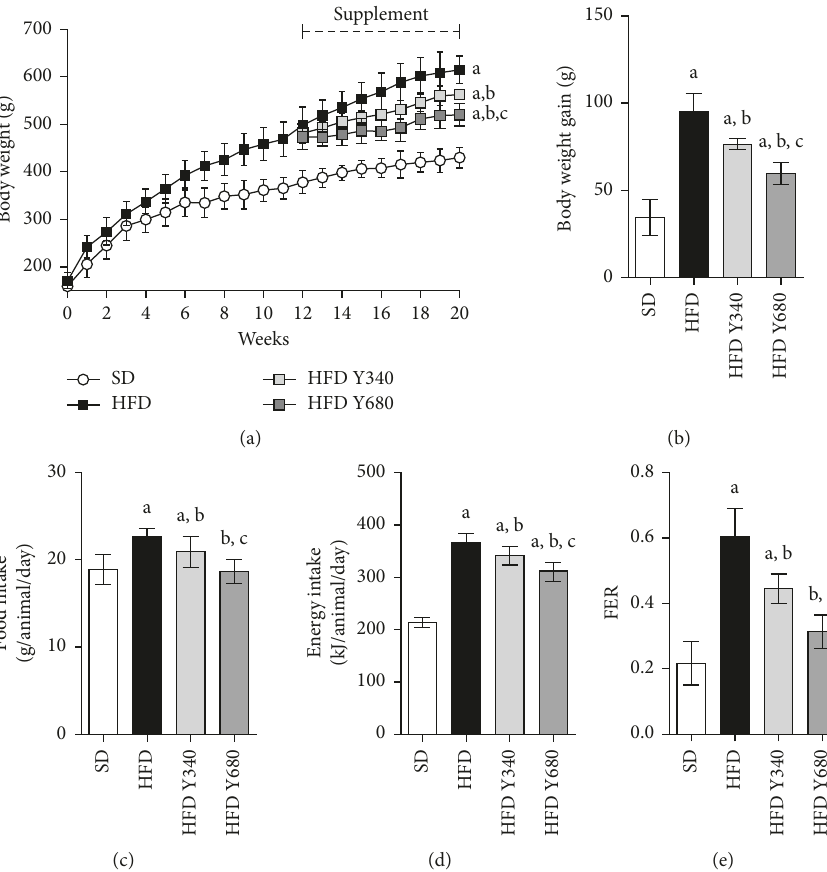
Figure 2: Effect of yacon flour on HFD-fed rats after 8 weeks of supplementation. (a) Time course of body weight in rats fed standard diet (SD) or high-fat diet (HFD) supplemented or not with yacon flour (340 or 680 mg FOS/kg body weight: HFD Y340 and HFD Y680, respectively). (b) Body weight gain. (c) Food intake. (d) Energy intake. (e) Feed efficiency ratio (FER). Data are mean ( n 6/group). a p 0 . 05 vs. SD group, b p 0 . 05 vs. HFD group, c p 0 . 05 vs. HFD Y340 (cid:31) <